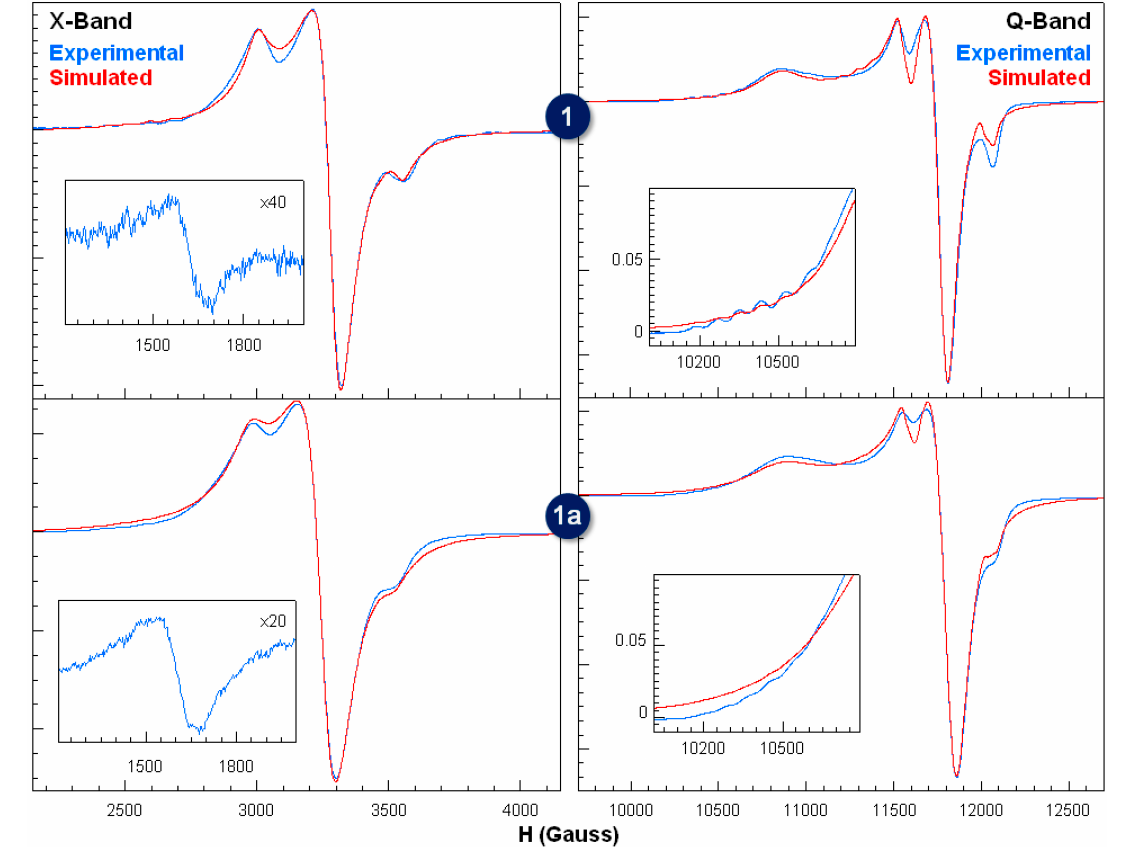
Figure 10. Experimental and simulated X- band (υ = 9.49 GHz) and Q-band (υ = 34.05 GHz) EPR spectra of 1 and 1a at room